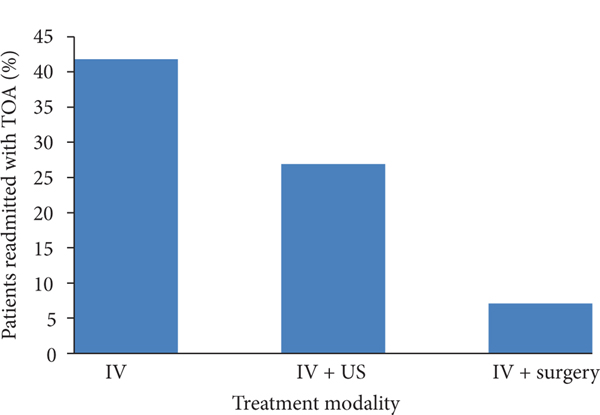
Proportion of readmission between treatment modalities. Readmission with TOA was different between all groups (P < 0.022). Post hoc comparison using Bonferroni’s correction showed the significant difference for readmission between the IV group and the IV/surgery group (P < 0.048).